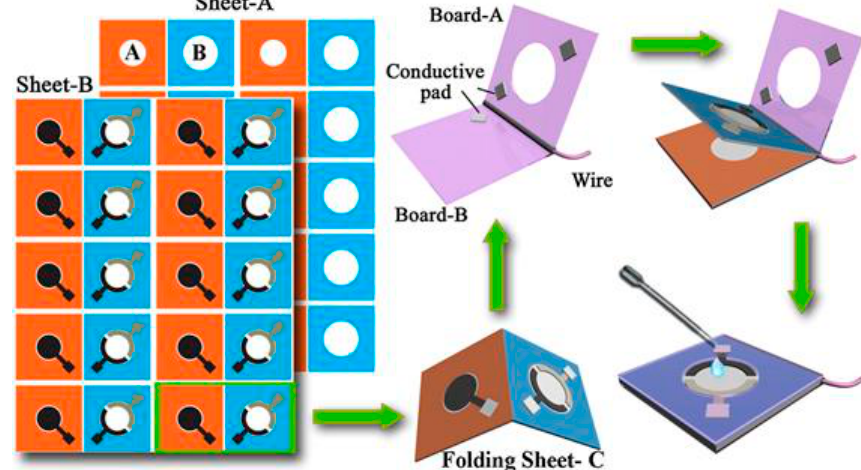
Figure 12. Schematic illustration of the fabrication and DNA assay procedure of the folding paper-based sensor device. Paper sheets were patterned in bulk using a wax printer and the three electrodes were screen-printed on wax-patterned sheets. Then, the sheet was cut to rectangular paper devices. Reproduced from [73], with permission from Elsevier, 2019.